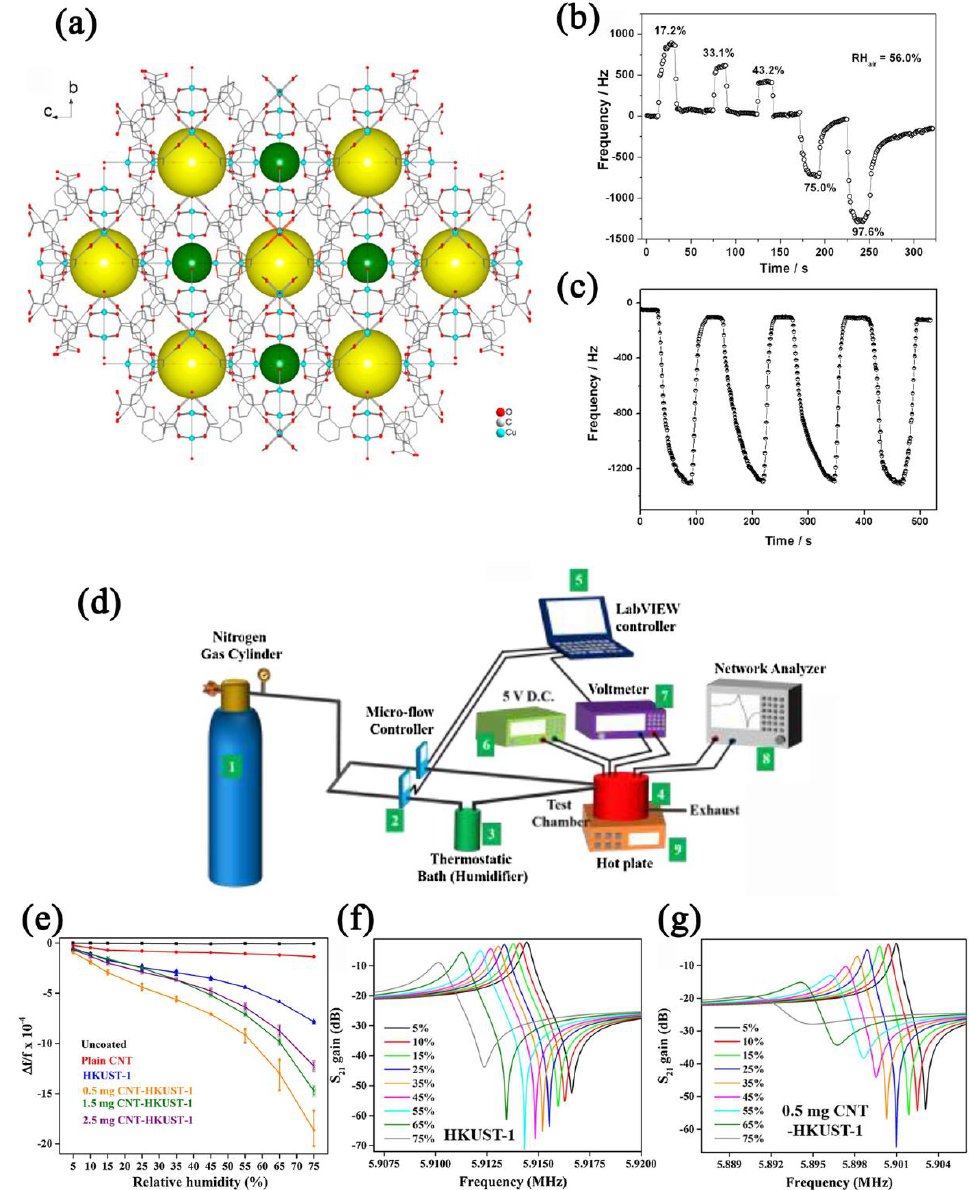
Figure 18. ( a ) Crystal structure of [Cu 3 L 2 (H 2 O) 2 . 75 ]·0.75H 2 O·1.75DMA. ( b ) Response curve